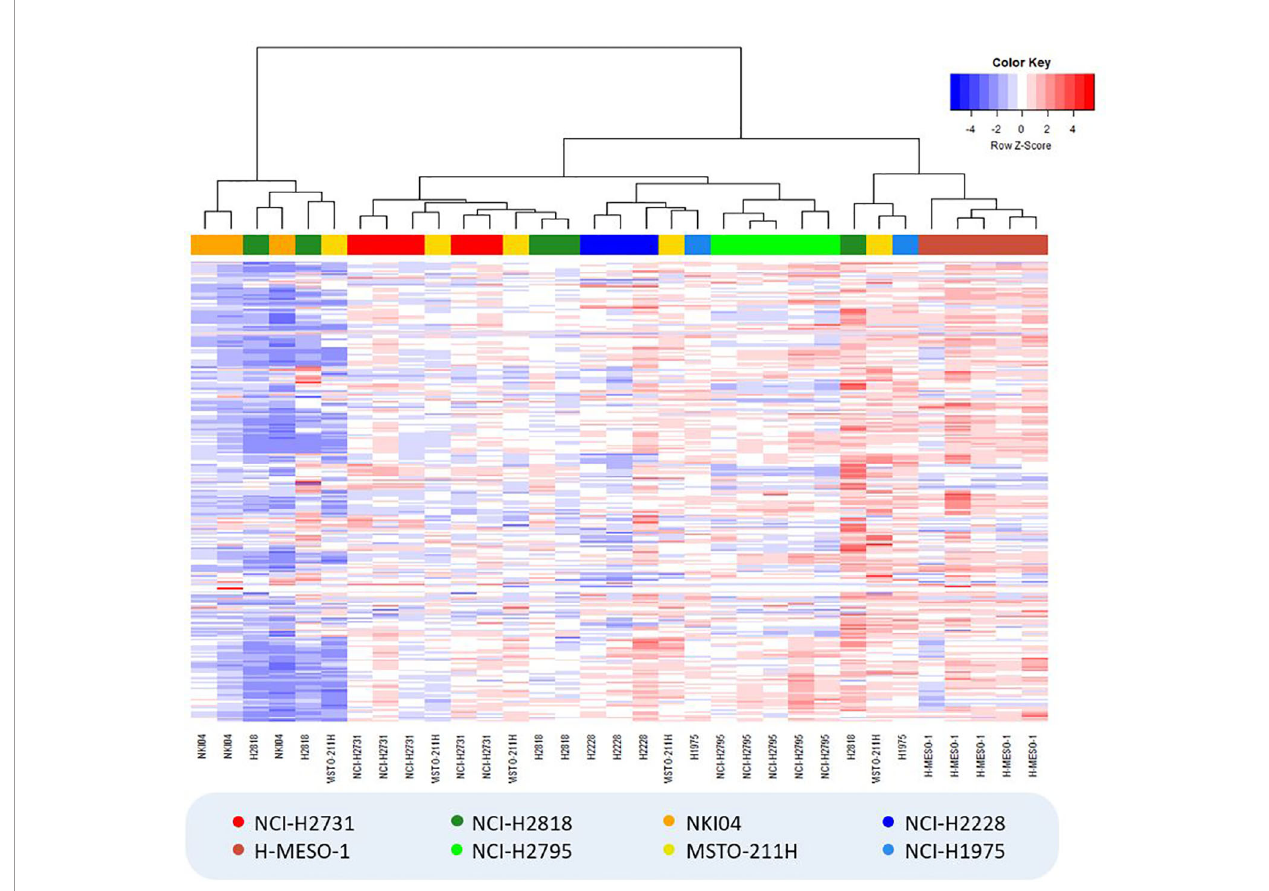
FIGURE 2 | Hierarchically clustered heatmap showing the result of hierarchical clustering analysis (Manhattan distance, Ward ’ s linkage) for all cell culture samples. VOC relative peak areas are shown in a color gradient, with blue colors indicating less produced VOCs (or more consumed VOCs in the case of negative background-corrected values) compared to the average of all samples (i.e. columns), while red colors indicate the exact opposite. Colors of the cell lines: light/dark green = epithelioid MPM; red/brown = sarcomatoid MPM; yellow/orange = biphasic MPM; dark/light blue = lung